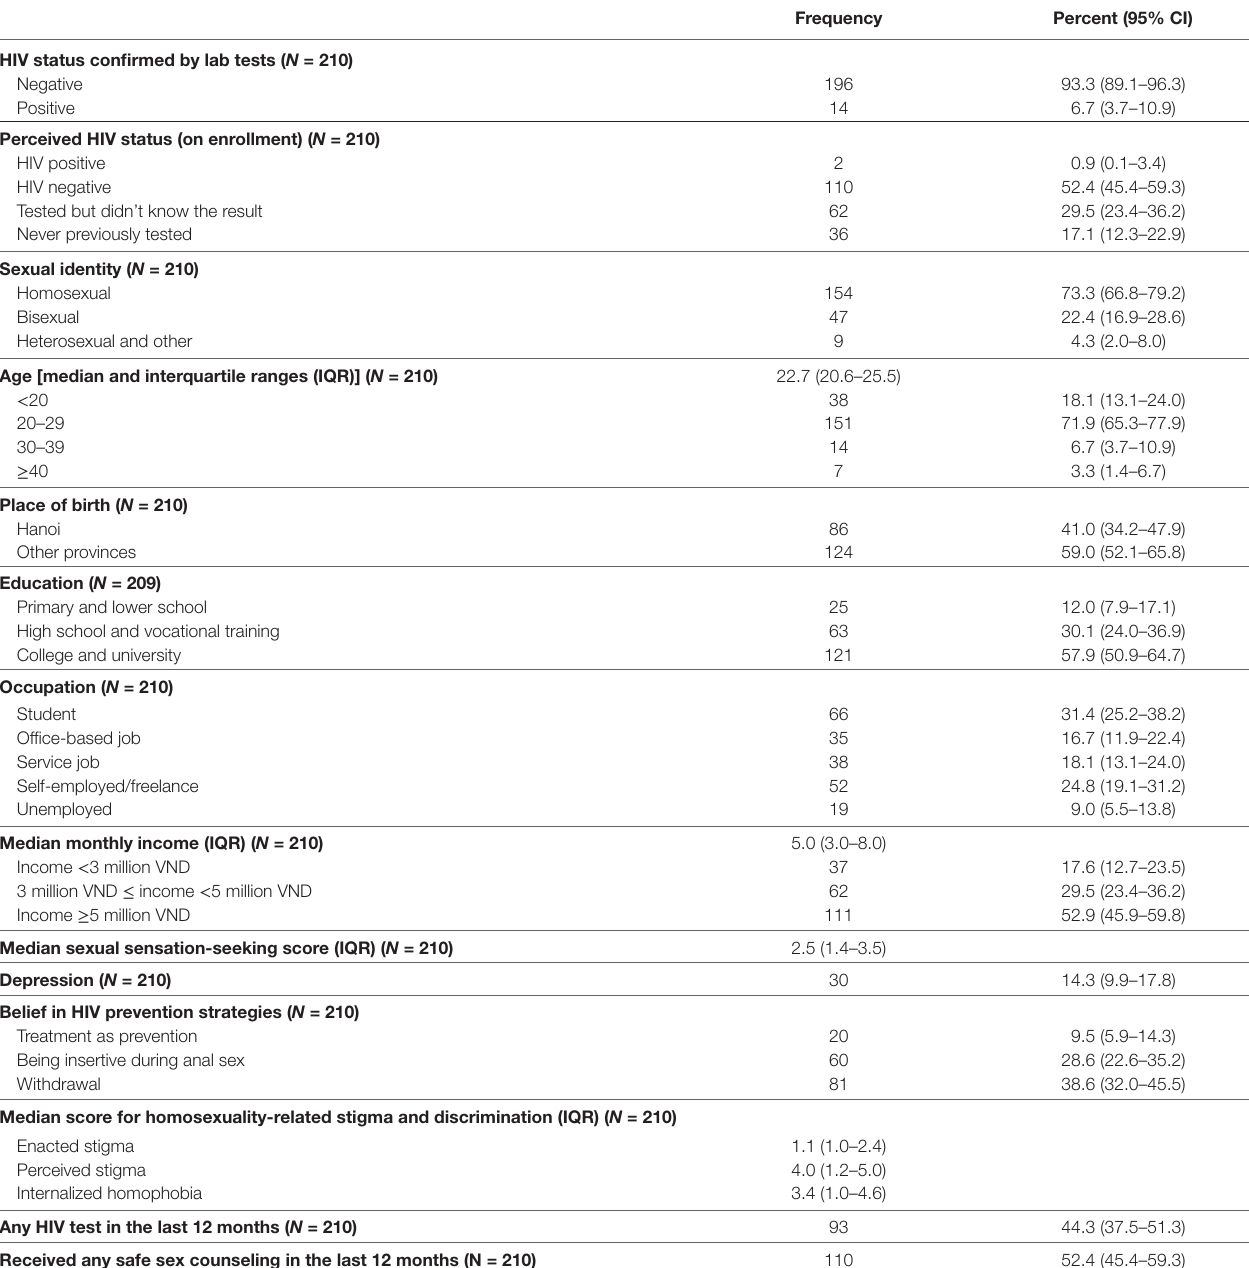
TaBle 1 | Participant